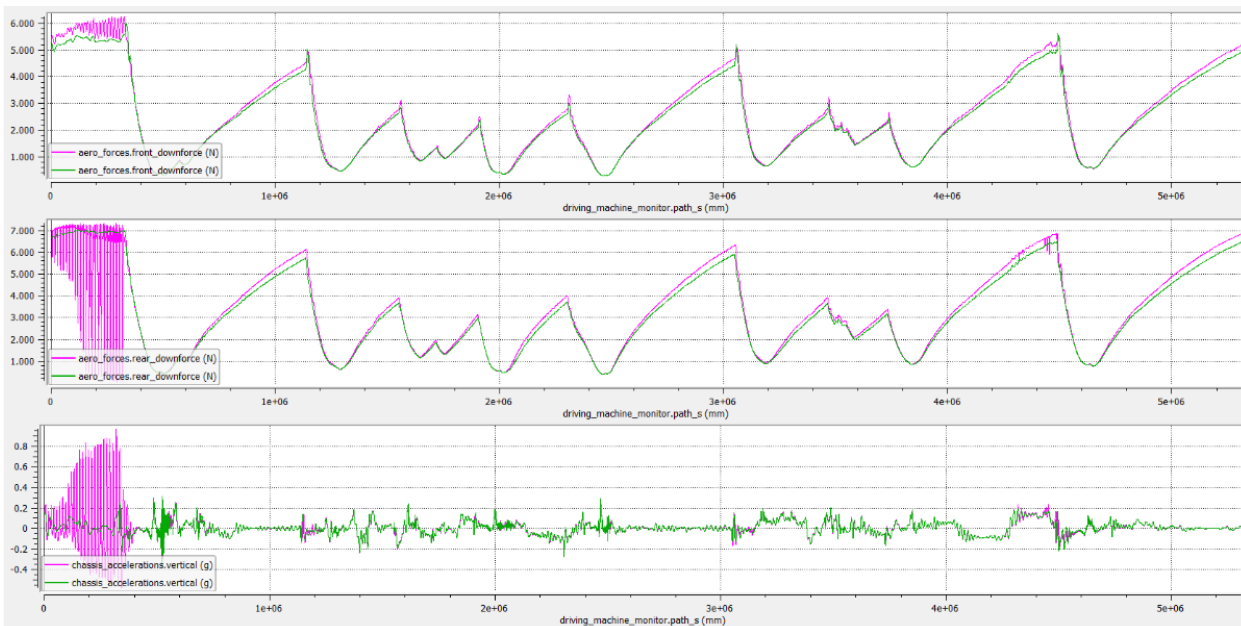
Top plot is the speed profile vs. lap distance, mid and bottom plots are the front and rear ride heights.